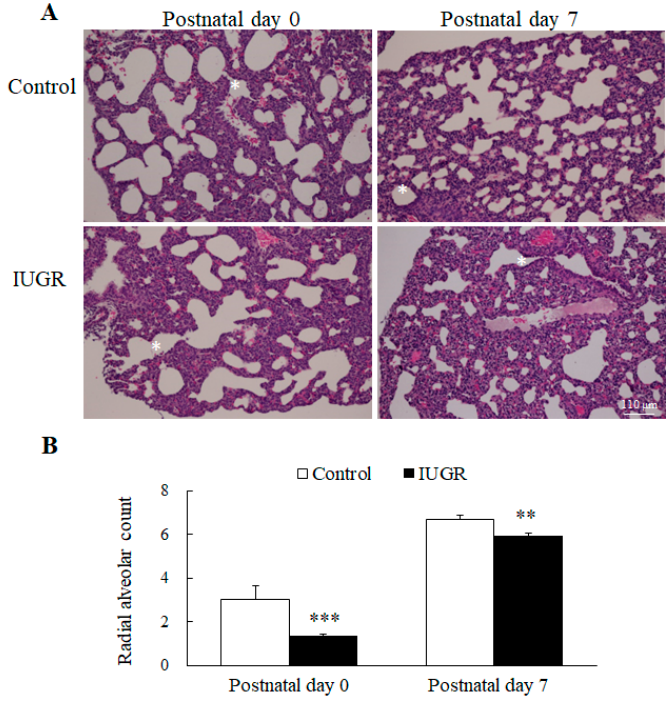
Figure 1. ( A ) Representative histological images of hematoxylin-and-eosin-stained murine lungs and ( B ) The radial alveolar count (RAC) of the lungs of control and intrauterine growth retardation (IUGR) rats on postnatal days 0 and 7. * denotes a respiratory bronchiole. Compared with the control rats, the IUGR rats exhibited a significantly lower RAC on these 2 days. n = 8–12 rats at each postnatal day. Data are presented as means ± standard deviations. ** p < 0.01, *** p < 0.001.